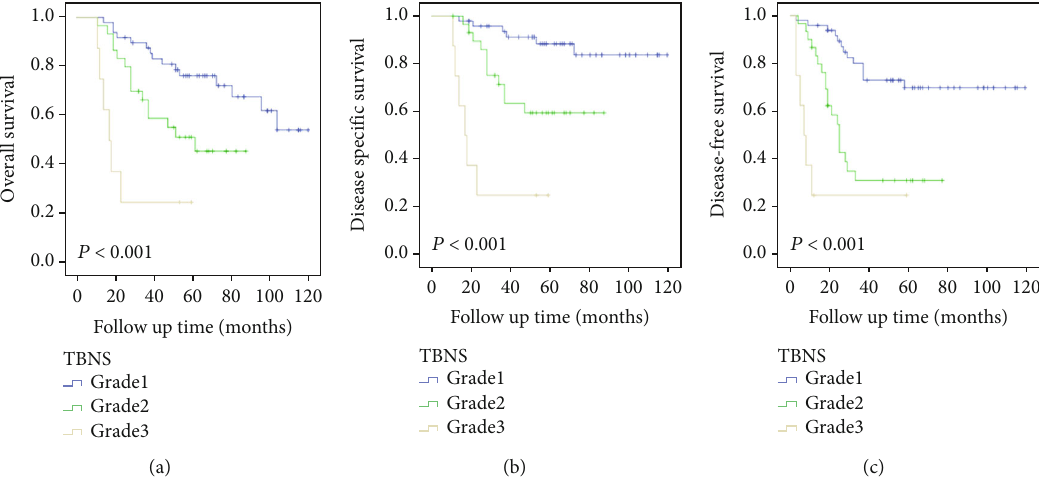
Figure 4: Association of the TBNS grade with overall survival (a), disease-speci fi c survival (b), and disease-free survival (c), in ureter urothelial